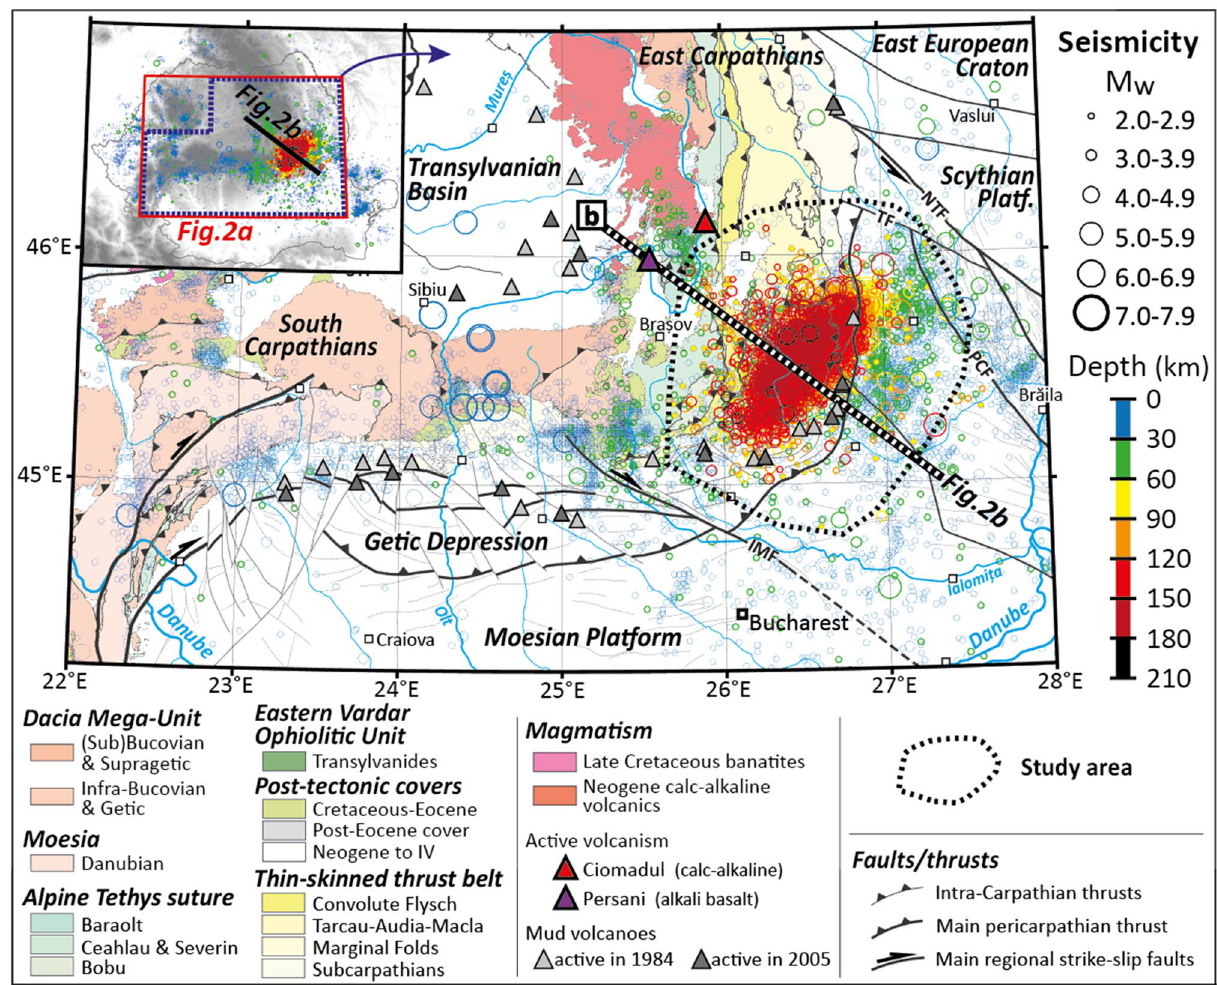
Figure 1. Intermediate-depth seismicity beneath Vrancea. ( a ) Synthetic geological map of central and eastern Romania, showing the location of epicentres for all seismic events (Mw ≥ 2) from 1940. Hypocentral depths are indicated with the colour scale. The study area is presented with the black contour. The locations of the 3D model (Fig. 2a) and interpreted profile (Fig. 2b) are shown on the top left inset. Map construction: